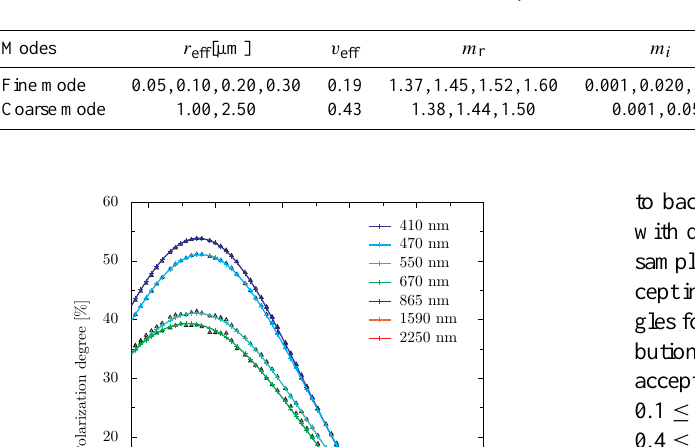
Figure 5. Comparison between retrieved and true values of aerosol optical depth ( τ 550 ), single scattering albedo ( ω 550 ) and aerosol pa- rameters ( r s , v s , m s r , m s , r c , v c , m c r and m c ) when the viewing angle number N = 5 using the full spectral range 410–2250nm. The eff eff i eff eff i correlation coefficients (cor), mean error ( (cid:49) ) and mean absolute error ( < (cid:49) > ) are included. Table 2. Parameters of fine and coarse modes used in lookup table retrieval.